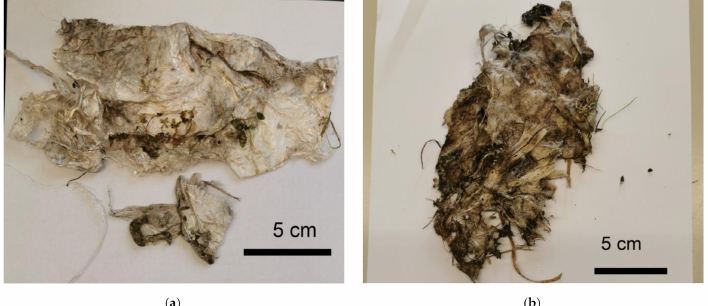
Figure 4. Photographs of a cellulose fibre sample from prototype 1, ( a ) 15 weeks, ( b ) 47 weeks of outdoor